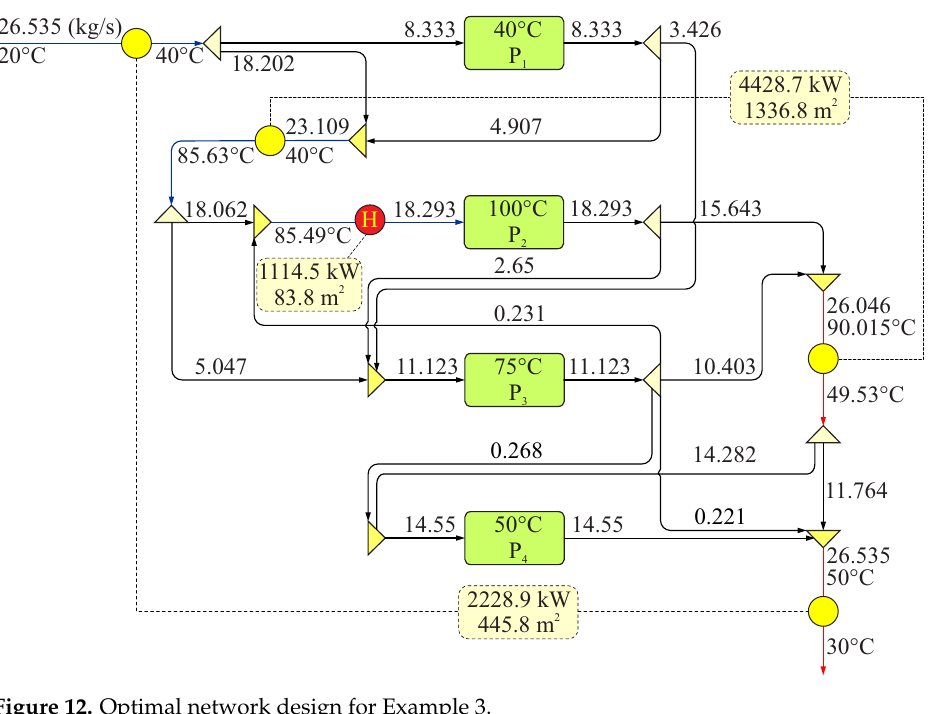
Figure 12. Optimal network design for Example 3. Table 6. Comparison of the results with those from the literature for Example